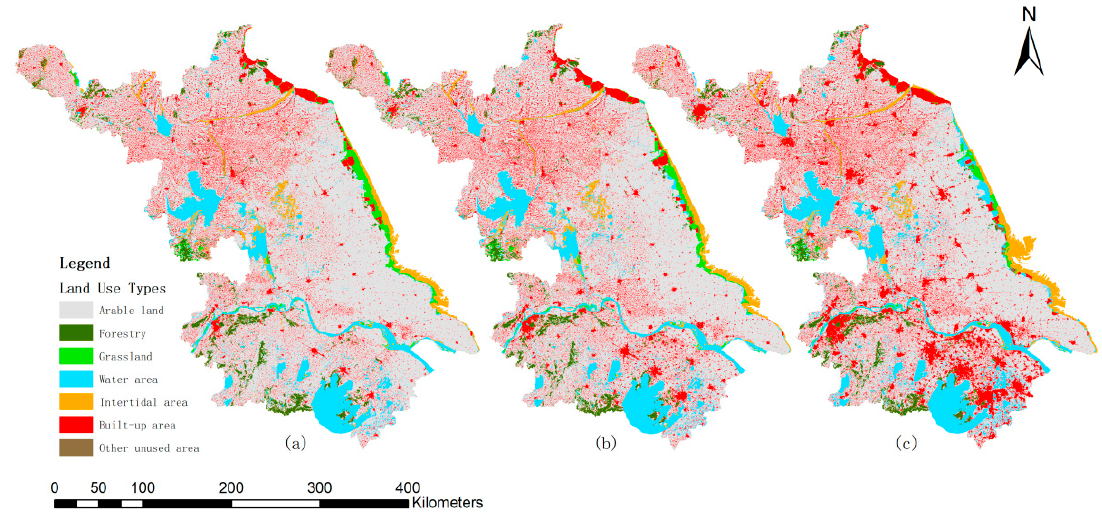
Figure 2. Land use classified map of Jiangsu province from 1990 to 2010: ( a ) Land use situation in 1990; ( b ) Land use situation in 2000; ( c ) Land use situation in 2010.